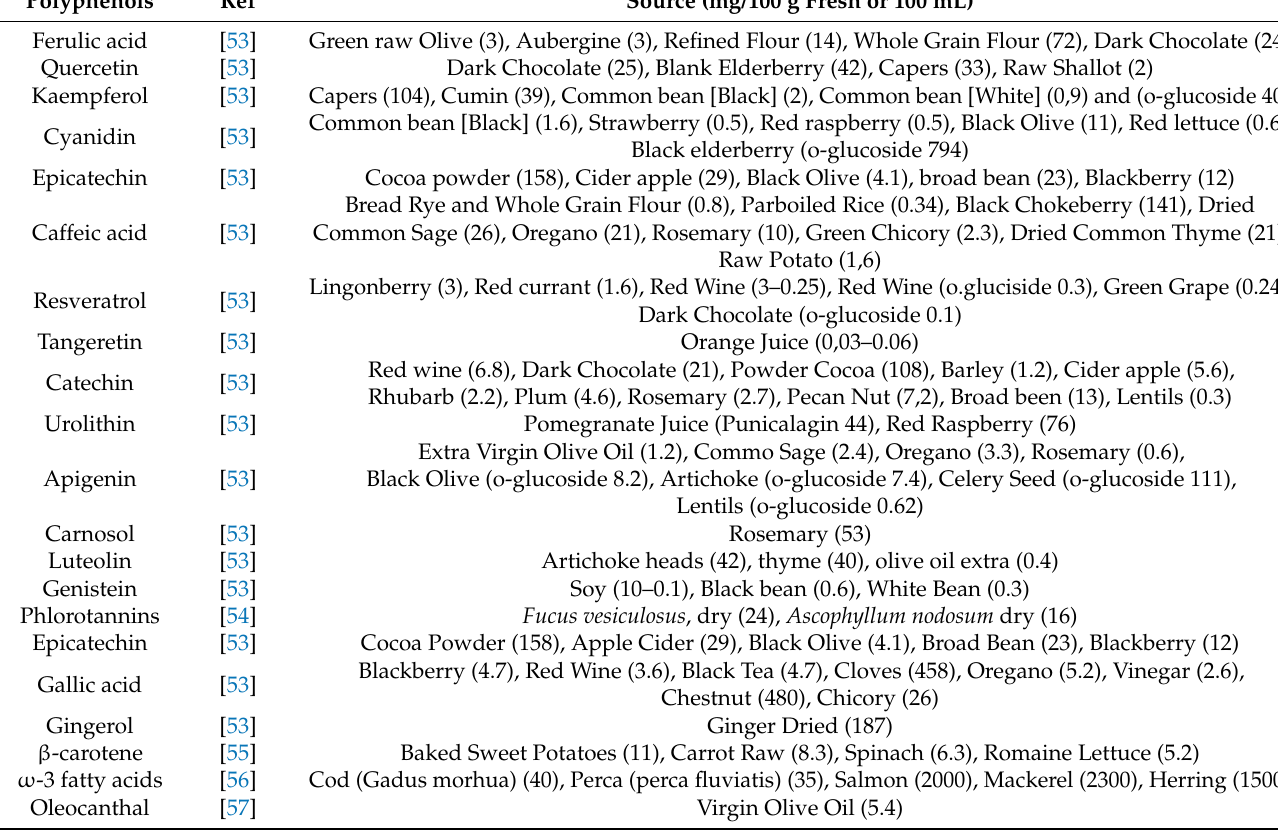
Table 1. Representation of the aliments present in the aforementioned diets with their main anti-inflammatory compounds.